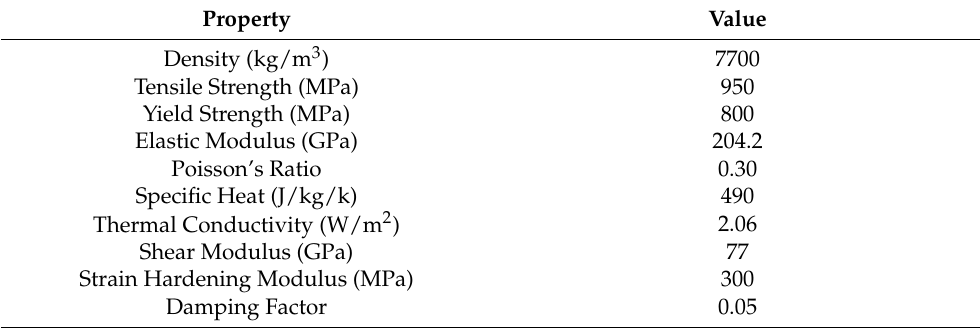
Table 2. Physical properties of X12Cr steel material [30].